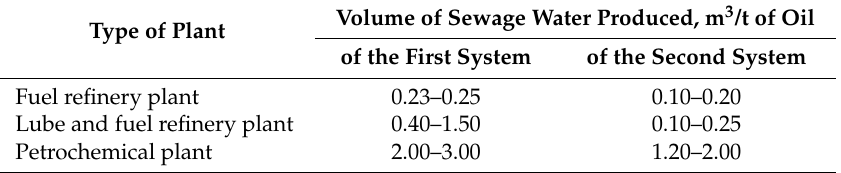
Table 5. Volume of sewage water produced in oil processing (per 1 t of oil) [3].